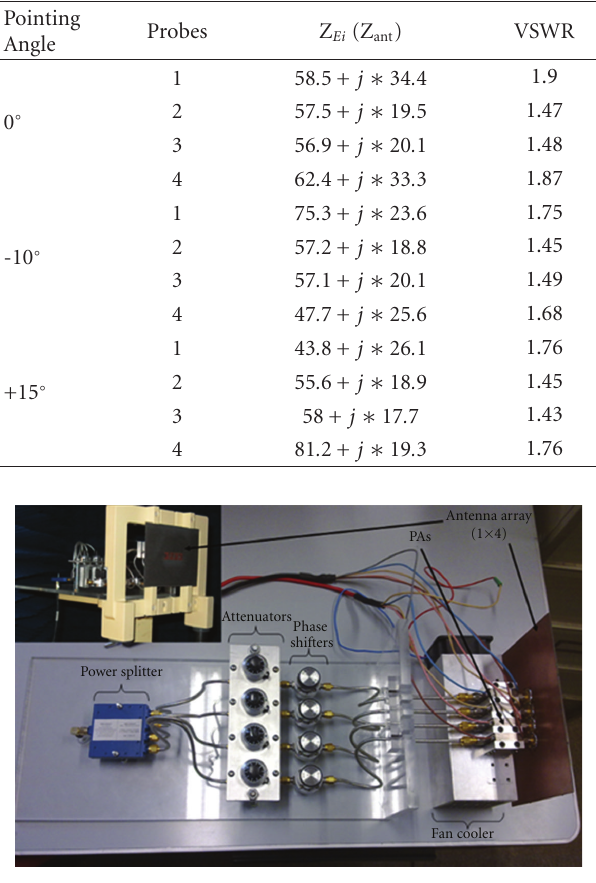
Figure 21: Phase Active antenna